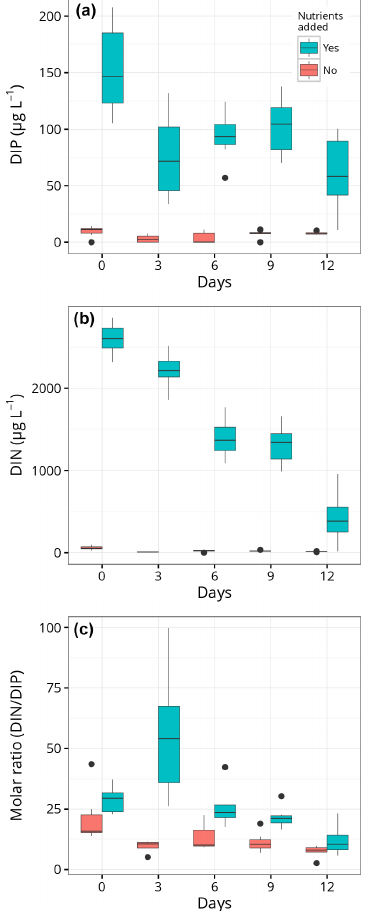
Figure 4. Temporal variation in the mesocosms units with and without nutrients additions for dissolved inorganic phosphorus- DIP (a) , dissolved inorganic nitrogen-DIN (b) and the molar ratio DIN / DIP (c) (center line: median; 5th/95th percentiles; 95% con- fidence level; black circles: